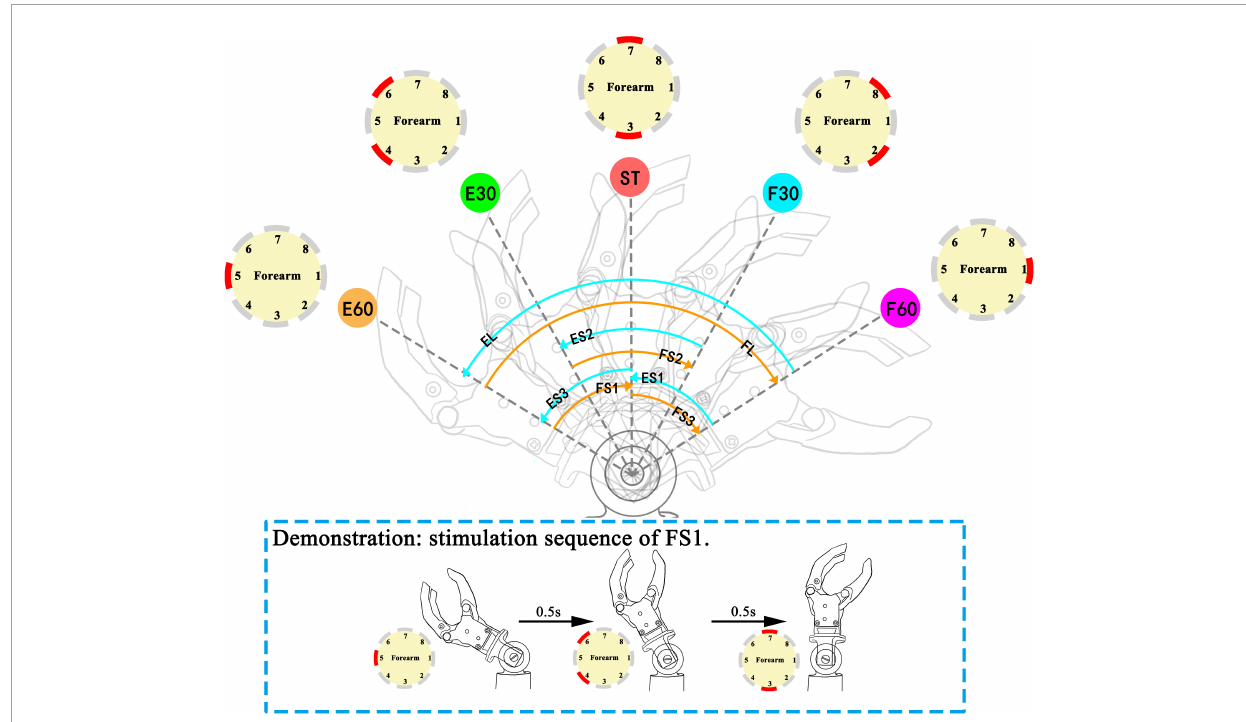
FIGURE4 Movement modes in the movement experiment: ES (ES1, extension small 1; ES2, extension small 2; ES3, extension small 3), EL (extension large), FS (FS1, flexion small 1; FS2, flexion small 2; FS3, flexion small 3), and FL (flexion large). The sequence of active channels and the corresponding movement modes: ES1 (CH1 → CH2, 8 → CH3, 7), ES2 (CH2, 8 → CH3, 7 → CH4, 6), ES3 (CH3, 7 → CH4, 6 → CH5), EL (CH1 → CH2, 8 → CH3, 7 → CH4, 6 → CH5), FS1 (CH5 → CH4, 6 → CH3, 7), FS2 (CH4, 6 → CH3, 7 → CH2, 8), FS3 (CH3, 7 → CH2, 8 → CH1), FL (CH5 → CH4, 6 → CH3, 7 → CH2, 8 → CH1). The red channel in channel maps represents the active (under stimulating) channel. Demonstration for stimulation sequence of FS1 is illustrated in dashed line